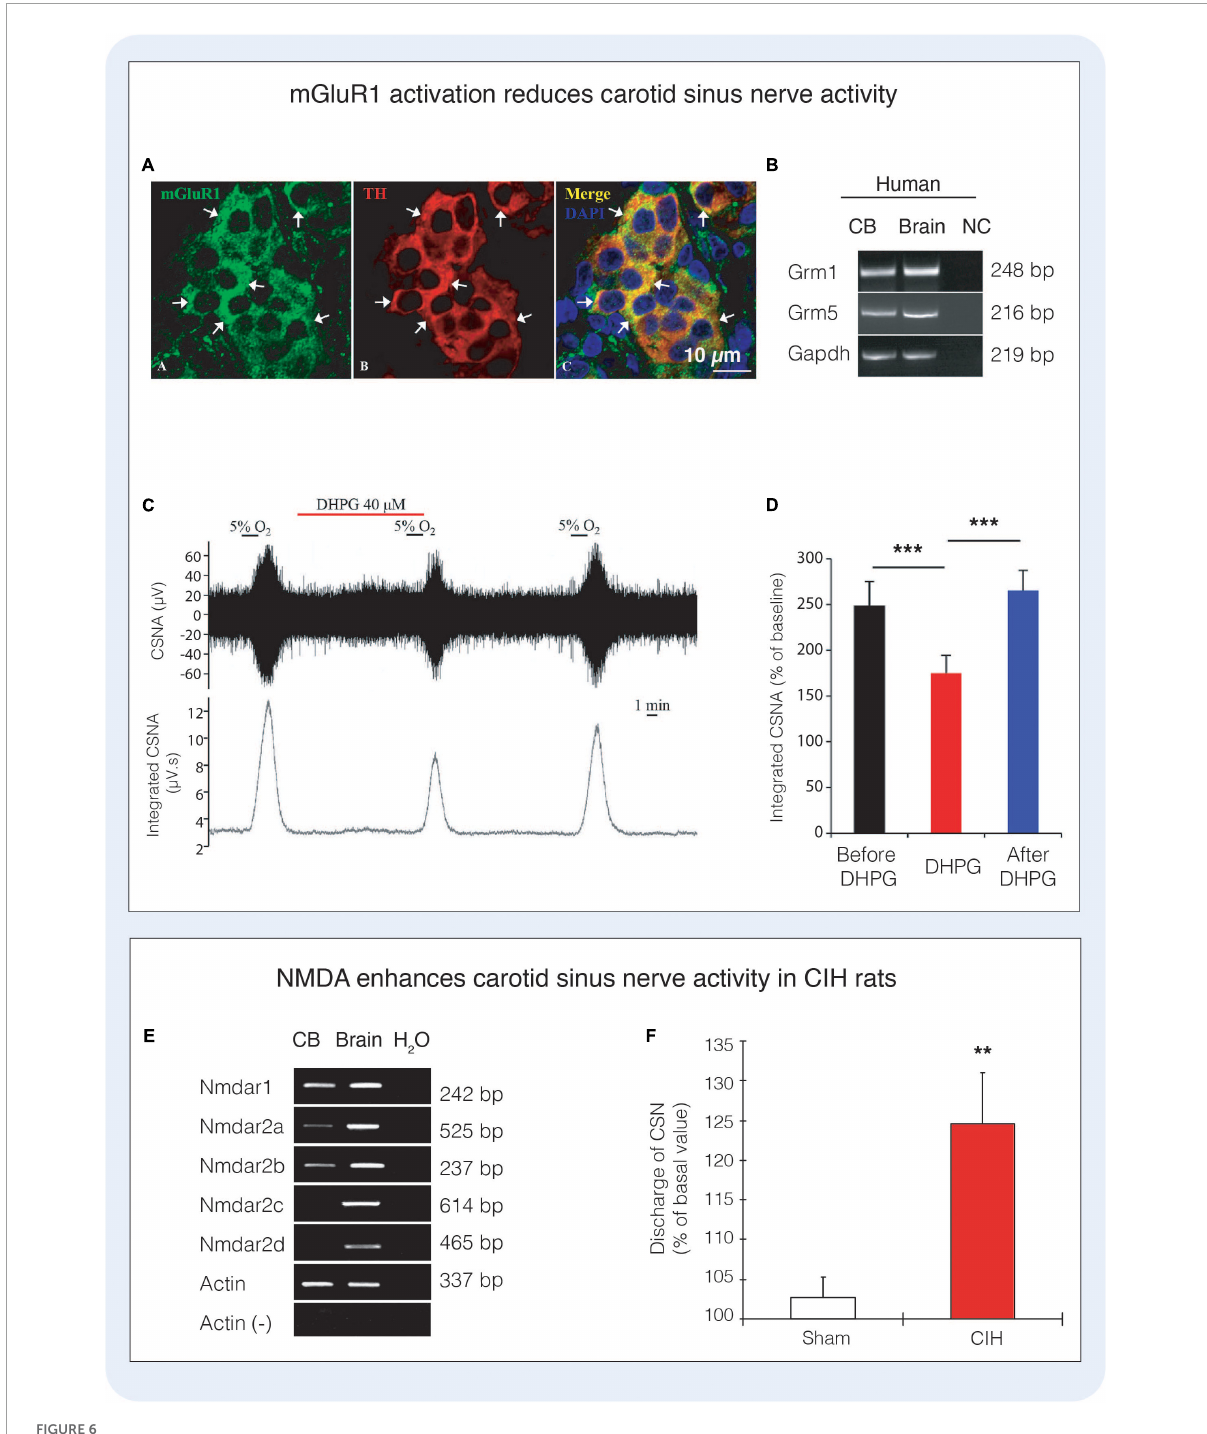
FIGURE6 Glutamate receptors and signaling in the carotid body. (A) Immunofluorescence depicts co-localisation of metabotropic glutamate receptor type 1 with tyrosine hydroxylase (TH) expressing type I cells in the rat carotid body. (B) RT-PCR highlights the expression of mRNA encoding mGluR1 and mGluR5 ( Grm1 , Grm5 ) in the human carotid body. (C,D) Activation of mGluR1 with the agonist 3,5-dihydroxyphenylglycine (DHPG) significantly reduces carotid sinus nerve activity (CSNA) in rat. Figures (A–D) reproduced with permission from Li et al. (2021). (E) The NMDA receptor subunits Nmdar1, Nmdar2a, Nmdar2b are present in the rat carotid body. (F) Administration of 40 µ M NMDA significantly increases carotid sinus nerve activity in rats exposed to chronic intermittent hypoxia (CIH), however NMDA did not alter the response to acute hypoxia (not shown). Figures (E,F) reproduced with permission from Liu et al.